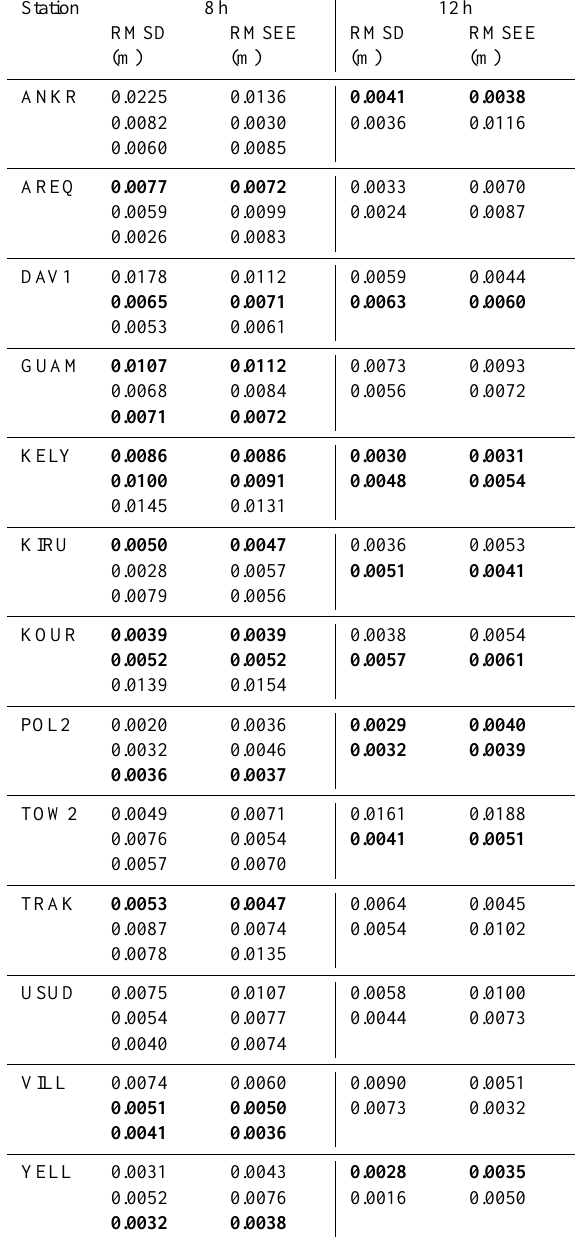
Table 5. Comparison of R 2 values from annual and monthly GPS campaigns for the height component using 24h solutions. The im- proved R 2 values from monthly analysis are shown with bold num- bers.